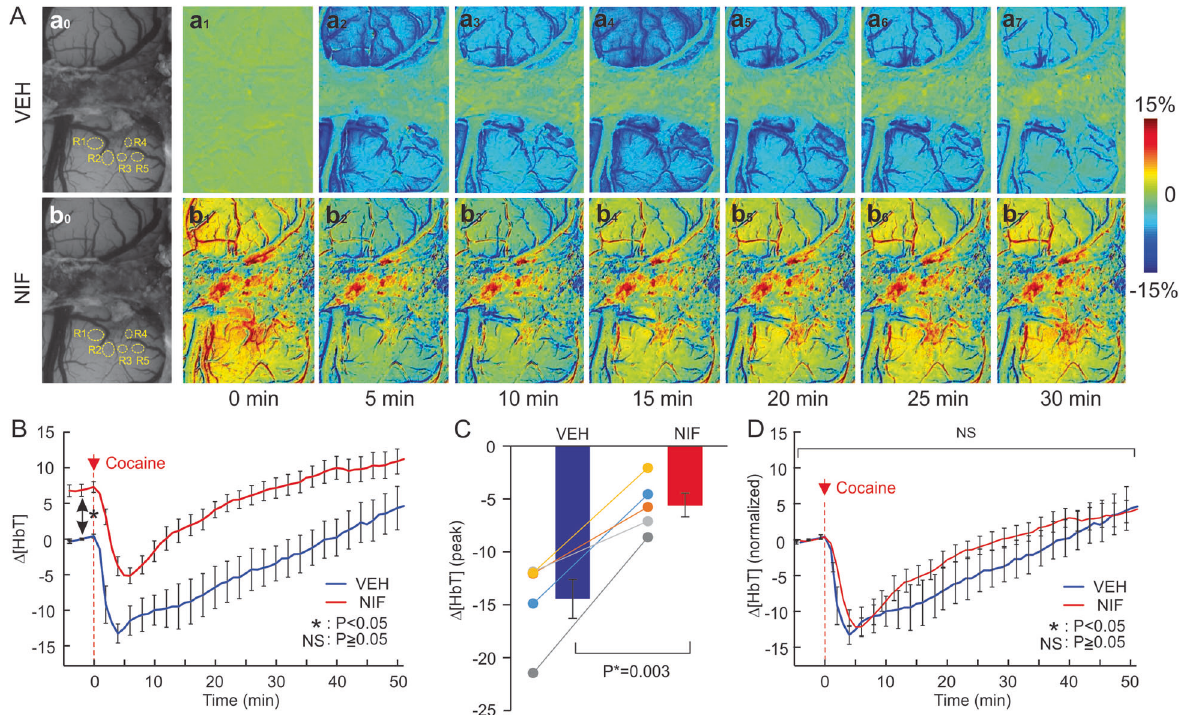
Fig. 3 Pretreatment of NIF increased blood volume and attenuated its absolute but not its relative reduction. A Representative images of the dynamic changes in cerebral blood volume ( Δ [HbT]) in response to cocaine (1 mg/kg, i.v.) in PFCs after vehicle (VEH, upper panel) and NIF- pretreatment (NIF, lower panel); Panels Aa 0 and Ab 0 show representative images for baseline before and after NIF (0.5 mg/kg, i.v.), respectively. B Dynamic measures of cocaine-induced cerebral blood volume ( Δ [HbT]) changes with vehicle and with NIF pretreatment (0.5 mg/kg, i.v.). C Comparison of the integrated decreases in Δ HbT ( n = 5) between vehicle and NIF pretreatment after cocaine. D Normalized dynamic change in ( Δ [HbT]) following cocaine at time t = 0 min. These results show that NIF pretreatment (0.5 mg/kg, i.v.) dilates vessels, elevating baseline cerebral blood volume and attenuated the non-normalized cocaine-induced ( Δ [HbT]) decreases. Values in graphs correspond to mean and standard errors. ROIs: the regions of interest. For a given animal these ROIs were placed in the same location in hemodynamic channels to the Ca 2 + fl uorescence channel. * p < 0.05; NS: not signi fi